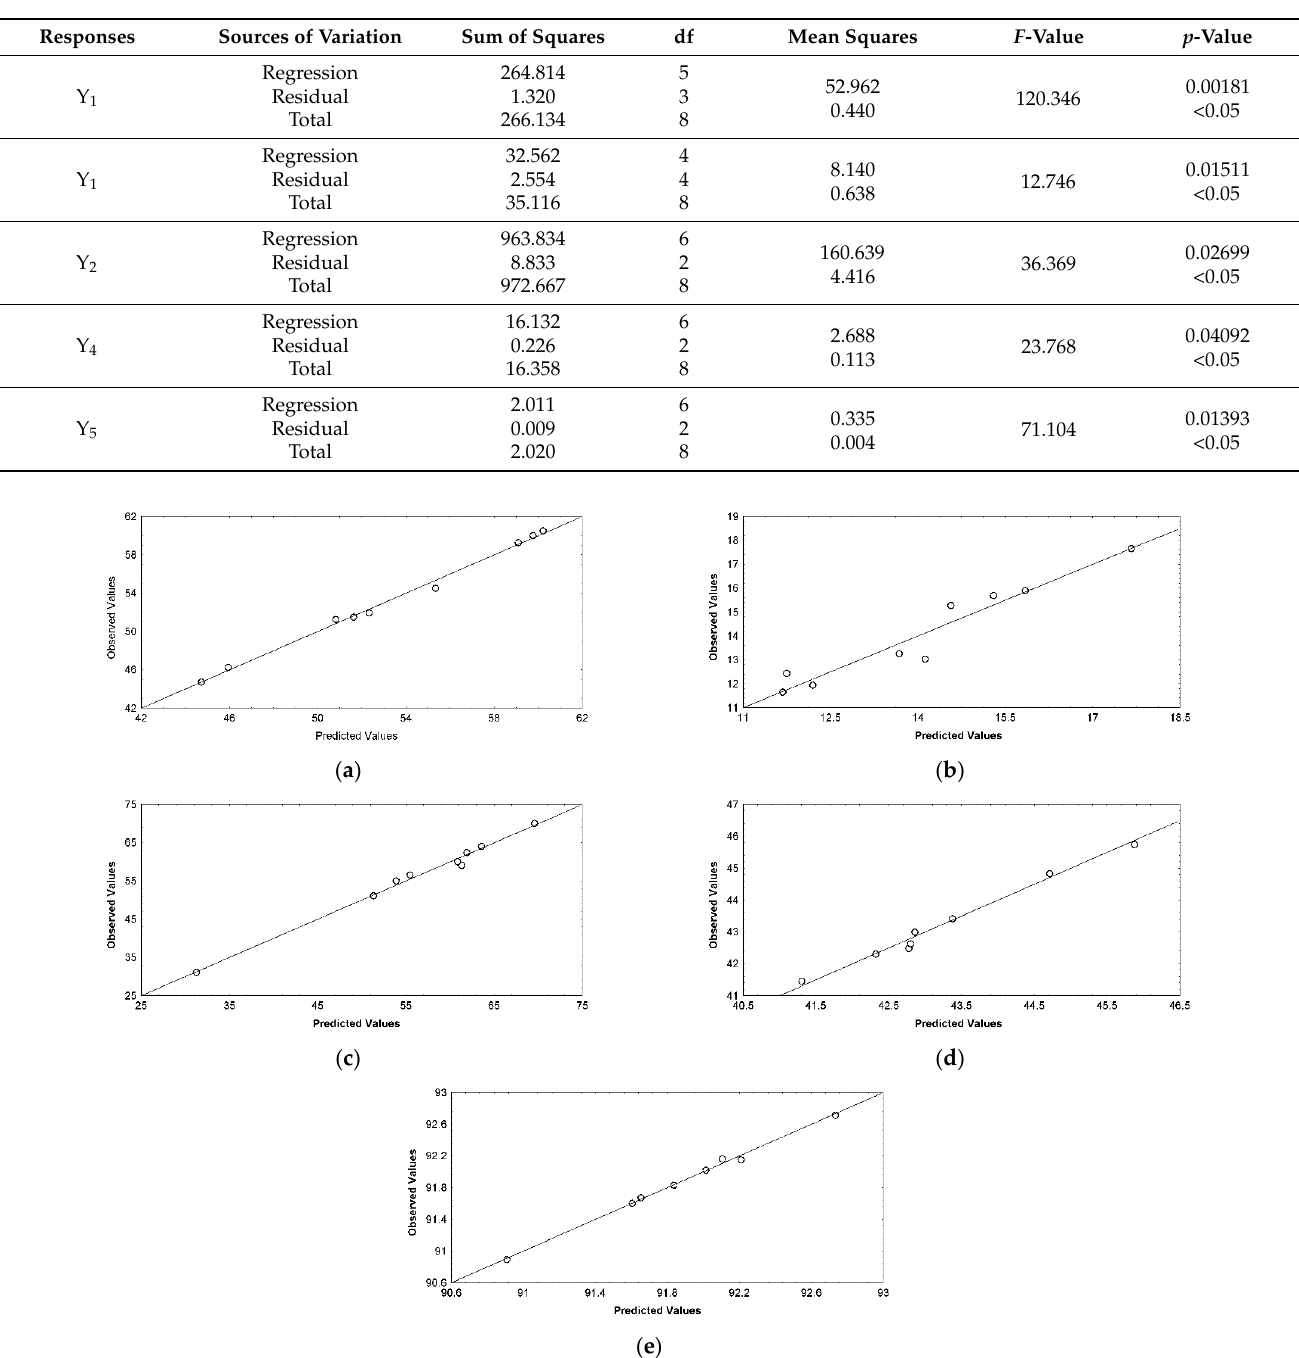
Table 4. Analysis of variance (ANOVA) for the reduced regression polynomial models.